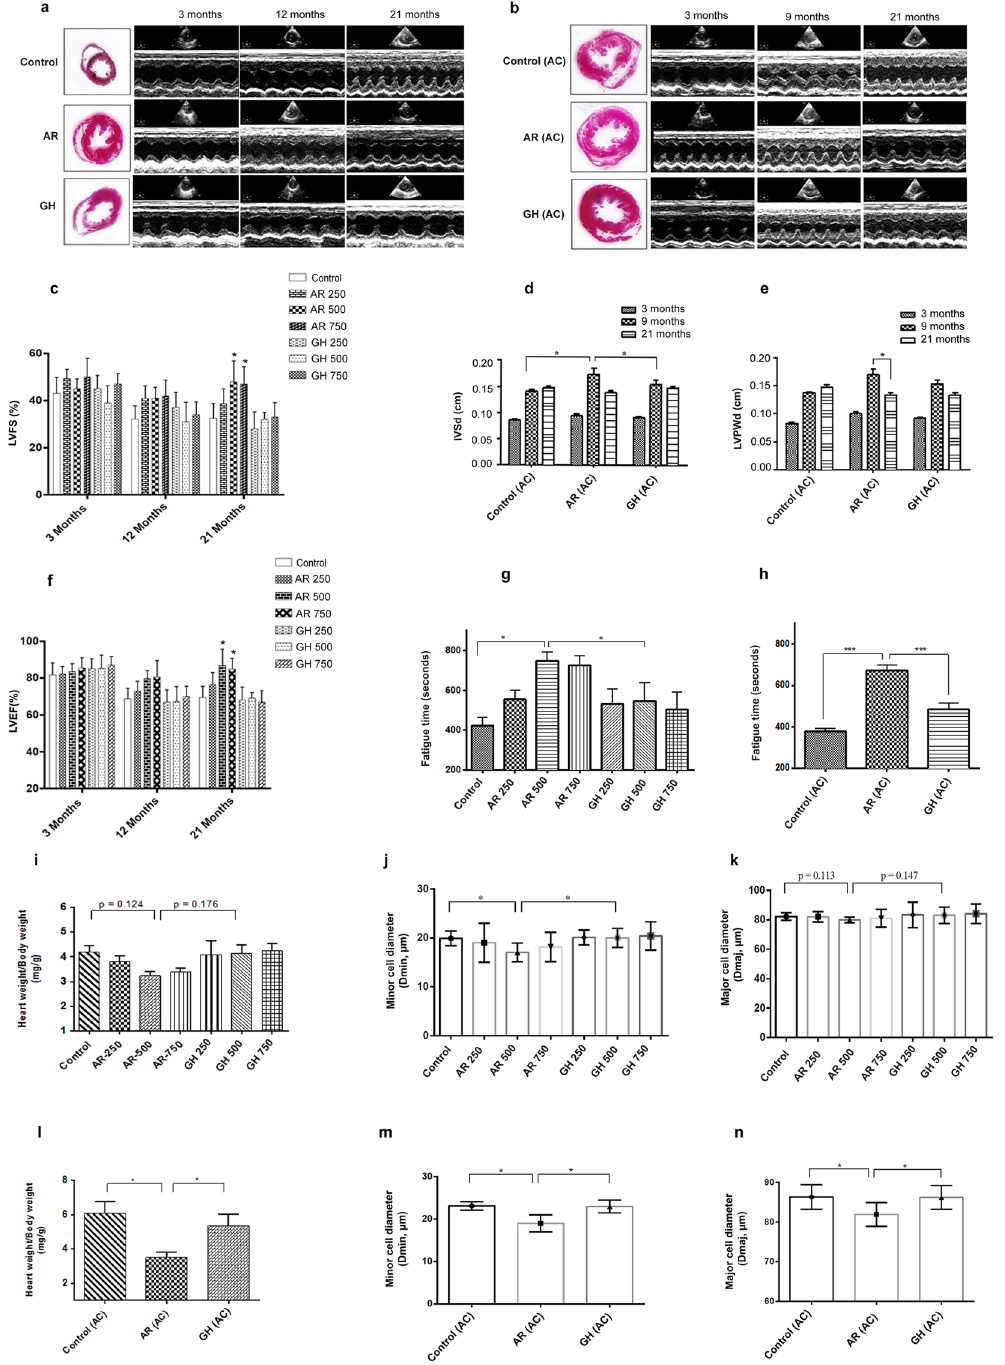
Figure 1. AR improved the left ventricular function in aging and aorta constricted group of rats. ( a ) Trichrome stained heart sections from 21 months old rats and representative M- mode echocardiography images of 3, 12 and 21 months old rats suggests unaltered left ventricular dimensions in AR treated rats. ( b ) Trichrome stained heart sections of 21 months rats with left ventricular hypertrophy (LVH) and representative M- mode echocardiography images of 3, 9 and 21 months rats with constricted aorta suggests sustained LV dimensions in AR treated rats. ( c , f ) Echocardiography measurements represents improved left ventricle dimensions and function in AR treated rats of aging group; LVEF (left ventricular ejection fraction), LVFS (left ventricular fractional shortening). ( d , e ) Echocardiography measurements suggests sustained left ventricle dimensions and function in AR administered rats of AC group. IVSd (diastolic interventricular septal thickness), LVPWd (diastolic left ventricle posterior wall thickness). ( g ) Fatigue times of 21 months old rats given different doses of AR or GH and control rats. ( h ) Fatigue times of 21 months old rats with constricted aorta and left ventricular hypertrophy. ( i , l ) Heart weight/body weight (mg/g) was lesser in AR administered rats and had reduced severe hypertrophy when compared with GH or control group in aging group. ( j , k ) Minor cell diameter (Dmin, μ